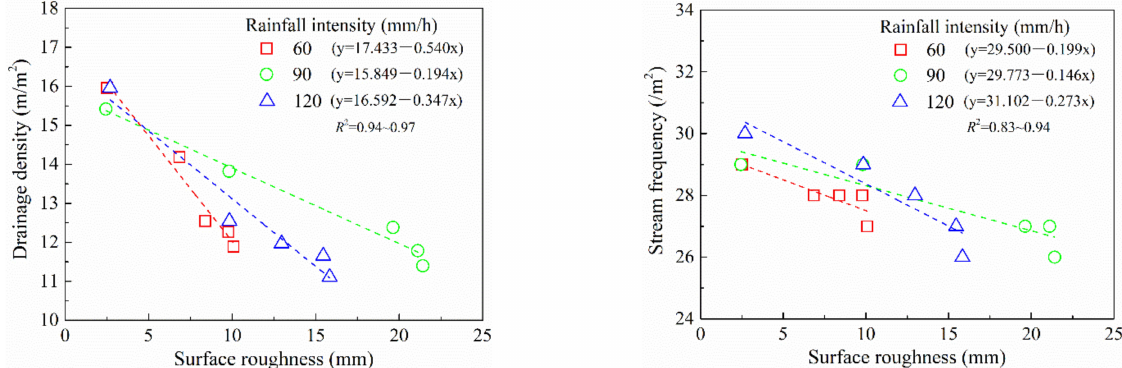
Figure 8. Relationships between surface roughness and drainage networks, stream